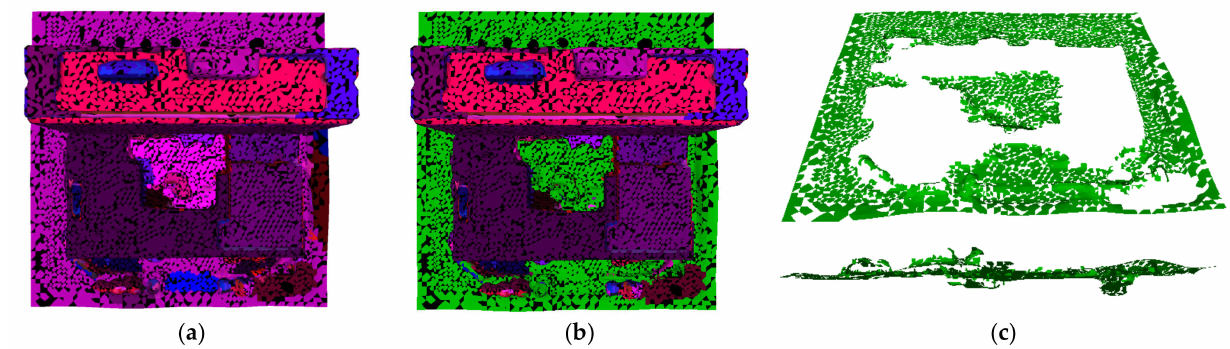
Figure 6. Ground extraction results. ( a ) is the top view of the result of regional growth, ( b ) is the result after extracting ground where the ground is highlighted in green, and ( c ) is the extracted ground region under the oblique and horizontal viewing